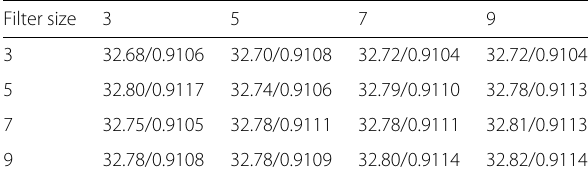
Table 1 The average PSNR (dB) and SSIM comparisons with our proposed method with different filter sizes on Set5 [1] Filter size